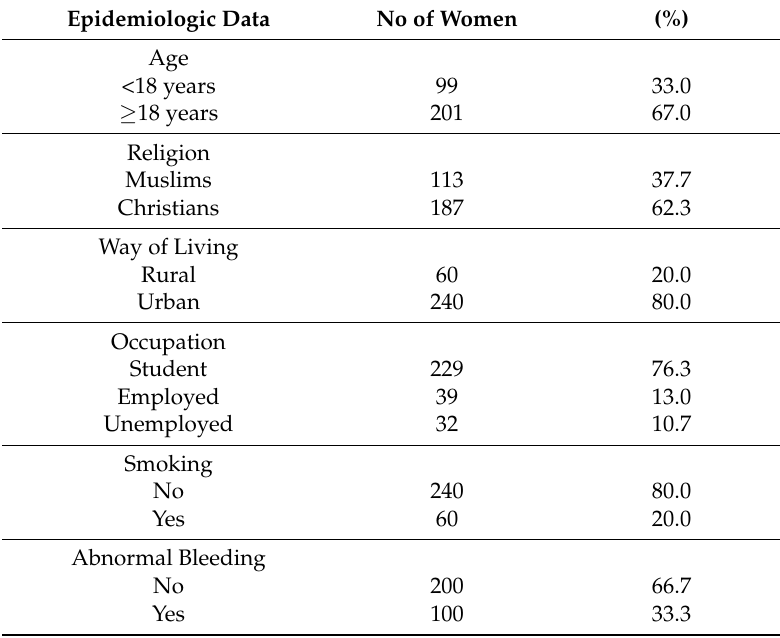
Table 1. Epidemiologic data of the study